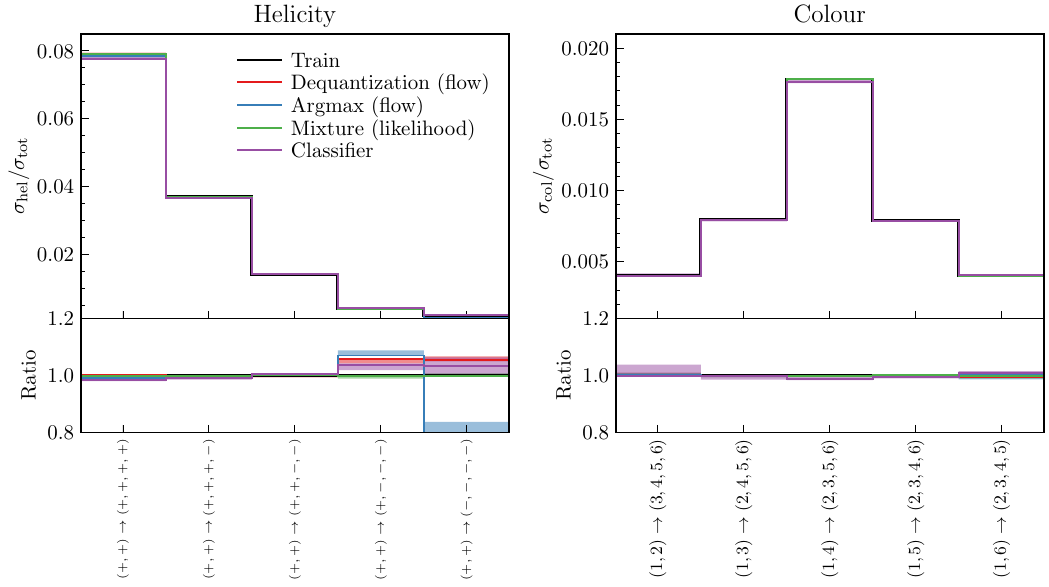
Figure 12: The marginalized discrete likelihoods of a subset of helicity and colour configurations as predicted by models with variational dequantization (red), argmax surjection (blue), the mixture model (green) and the classifier model (purple). In all cases, a sorting surjection was used. The error bands correspond with variations between three independent